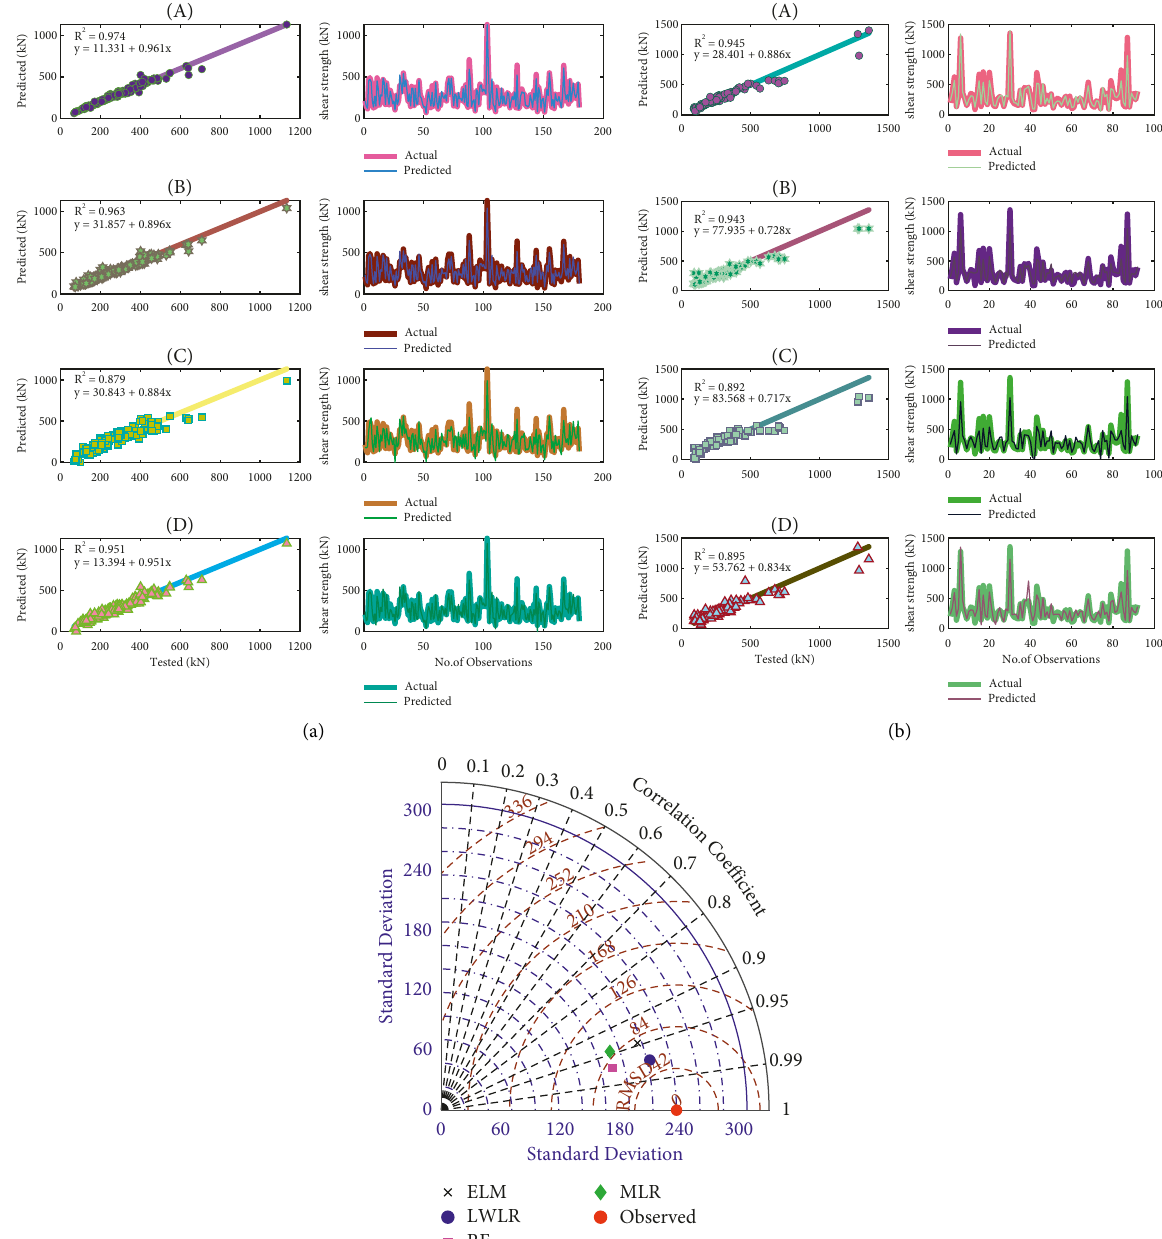
Figure 6: A comparison between the objectives of the models: (A)–(D) represent the LWLR, RF, MLR, and ELM models, respectively. Figures (a) and (b) show scatter plots and line plots for the training and test data, respectively, while figure (c) is a Taylor plot based on the test data. (a) Training data. (b) Testing data. (c) Taylor